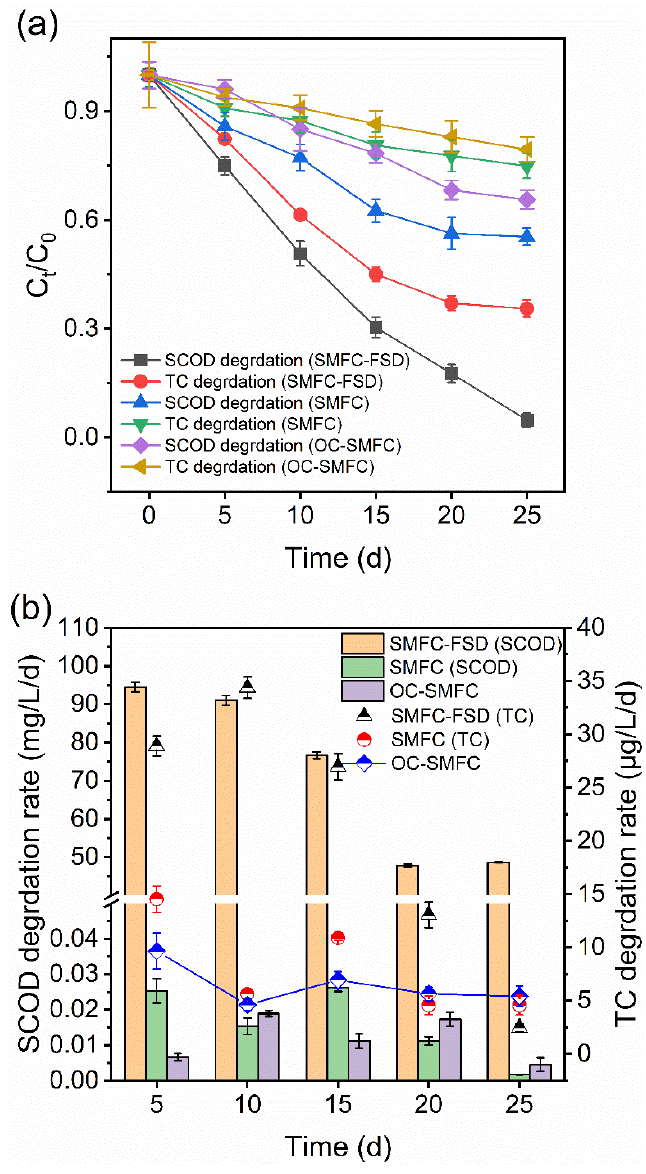
Figure 2. Degradation performance ( a ) of SCOD and TC in the drenching solution of SMFC, SMFC- FSD and OC-SMFC with a five-day interval. The degradation rate ( b ) of SCOD and TC in different SMFC reactors: 5. 10, 15, 20, and 25 represent the average degradation rate in the 0–5th day, 5–10th day, 10–15th day, 15–20th day and 20–25th day,